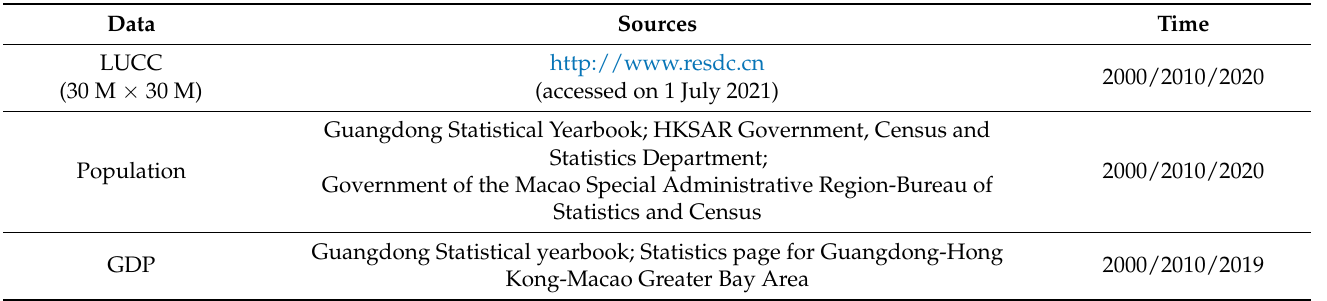
Table 7. Data sources.